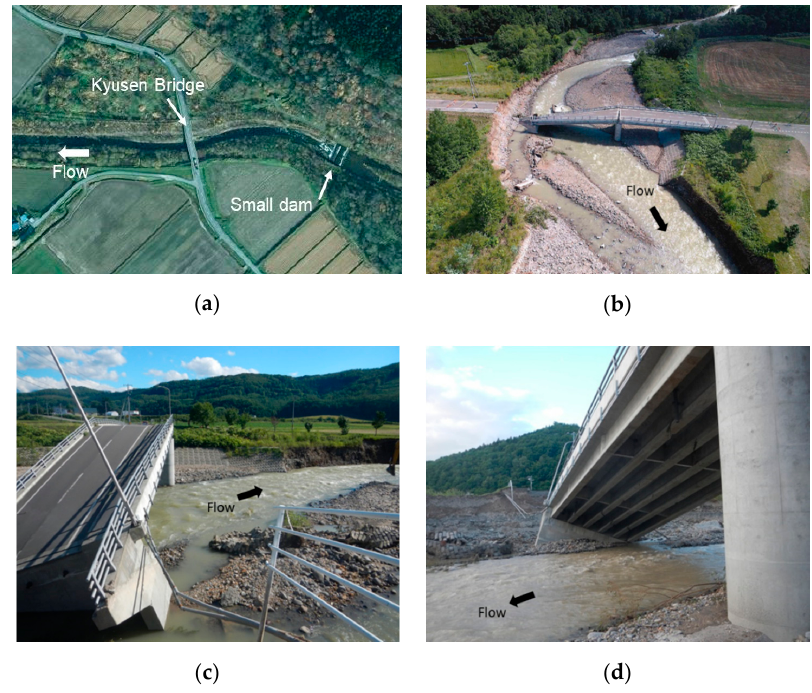
Figure 2. ( a ) and ( b ) Aerial photos of Kyusen Bridge (43°35’59.0” N 142°37’00.1” E) before and after Figure 2. ( a , b ) Aerial photos of Kyusen Bridge (43 ◦ 35 (cid:48) 59.0” N 142 ◦ 37 (cid:48) 00.1” E) before and after the 2016 the 2016 flood. ( c ) and ( d ) Close up views from the right and left banks, respectively. flood. ( c , d ) Close up views from the right and left banks,